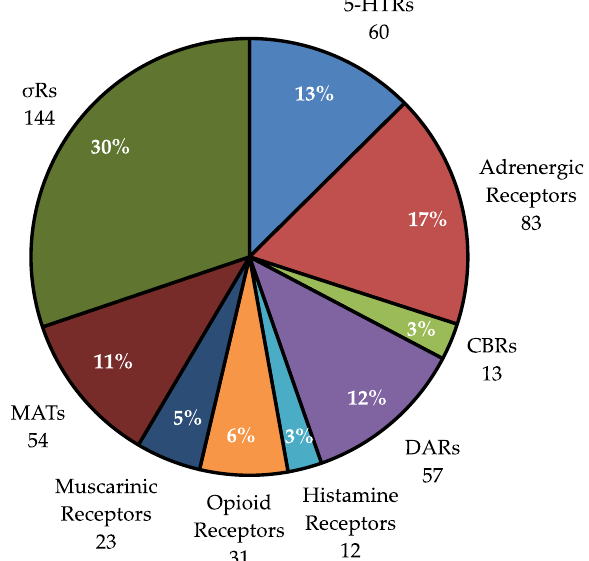
Figure 6. Percent of hits at each receptor group. (446 total hits, number of hits at each group is listed inside of graph).